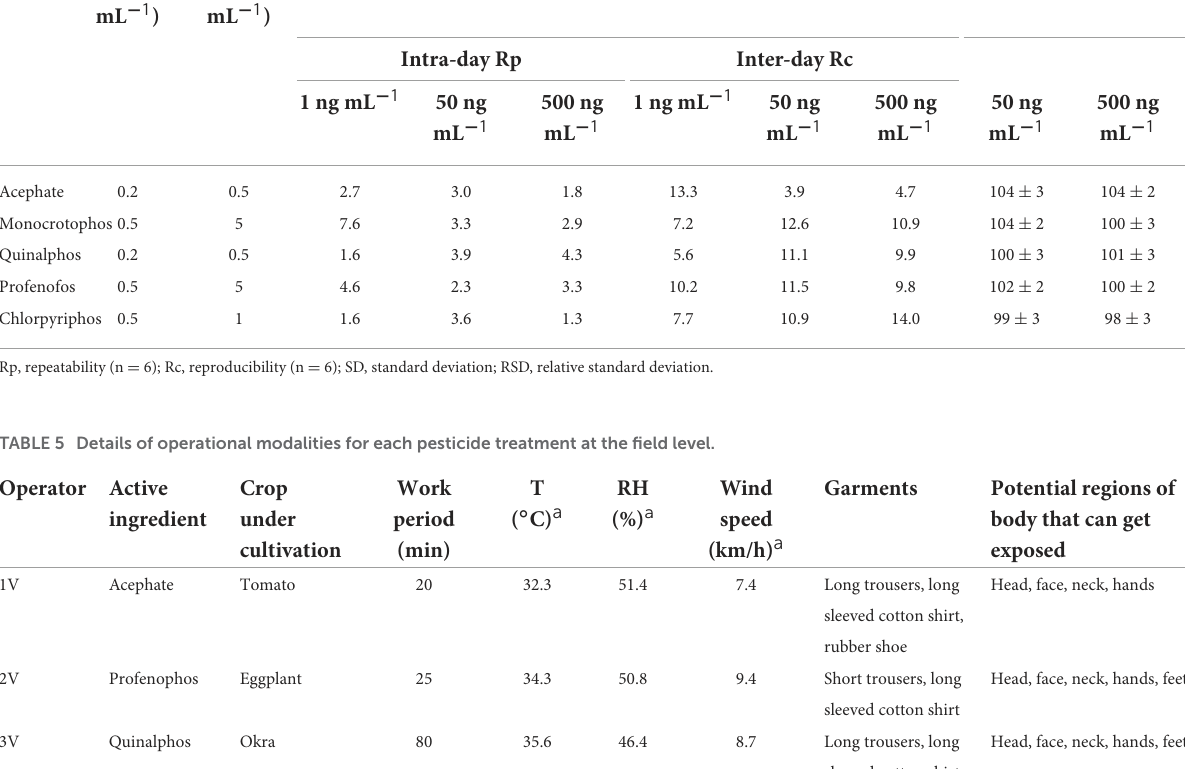
TABLE 4 Performance parameters of the LC-MS/MS method for the determination of pesticide residues in wipe/patch. Analyte LOD (ng